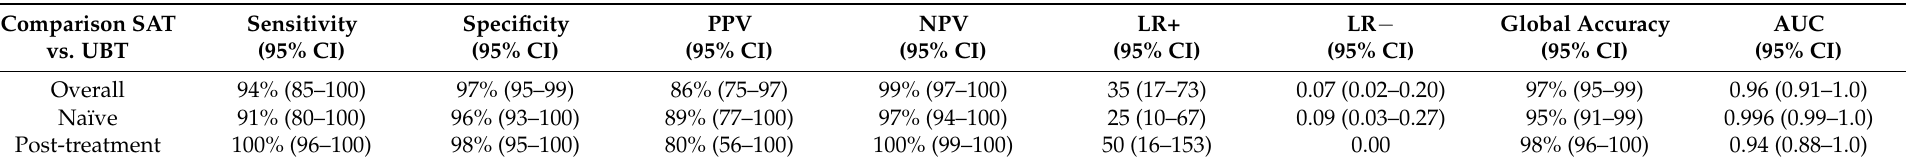
Table 4. Accuracy of the LIAISON ® Meridian H. pylori SA test after performing PCR in stool of discordant samples. Comparison